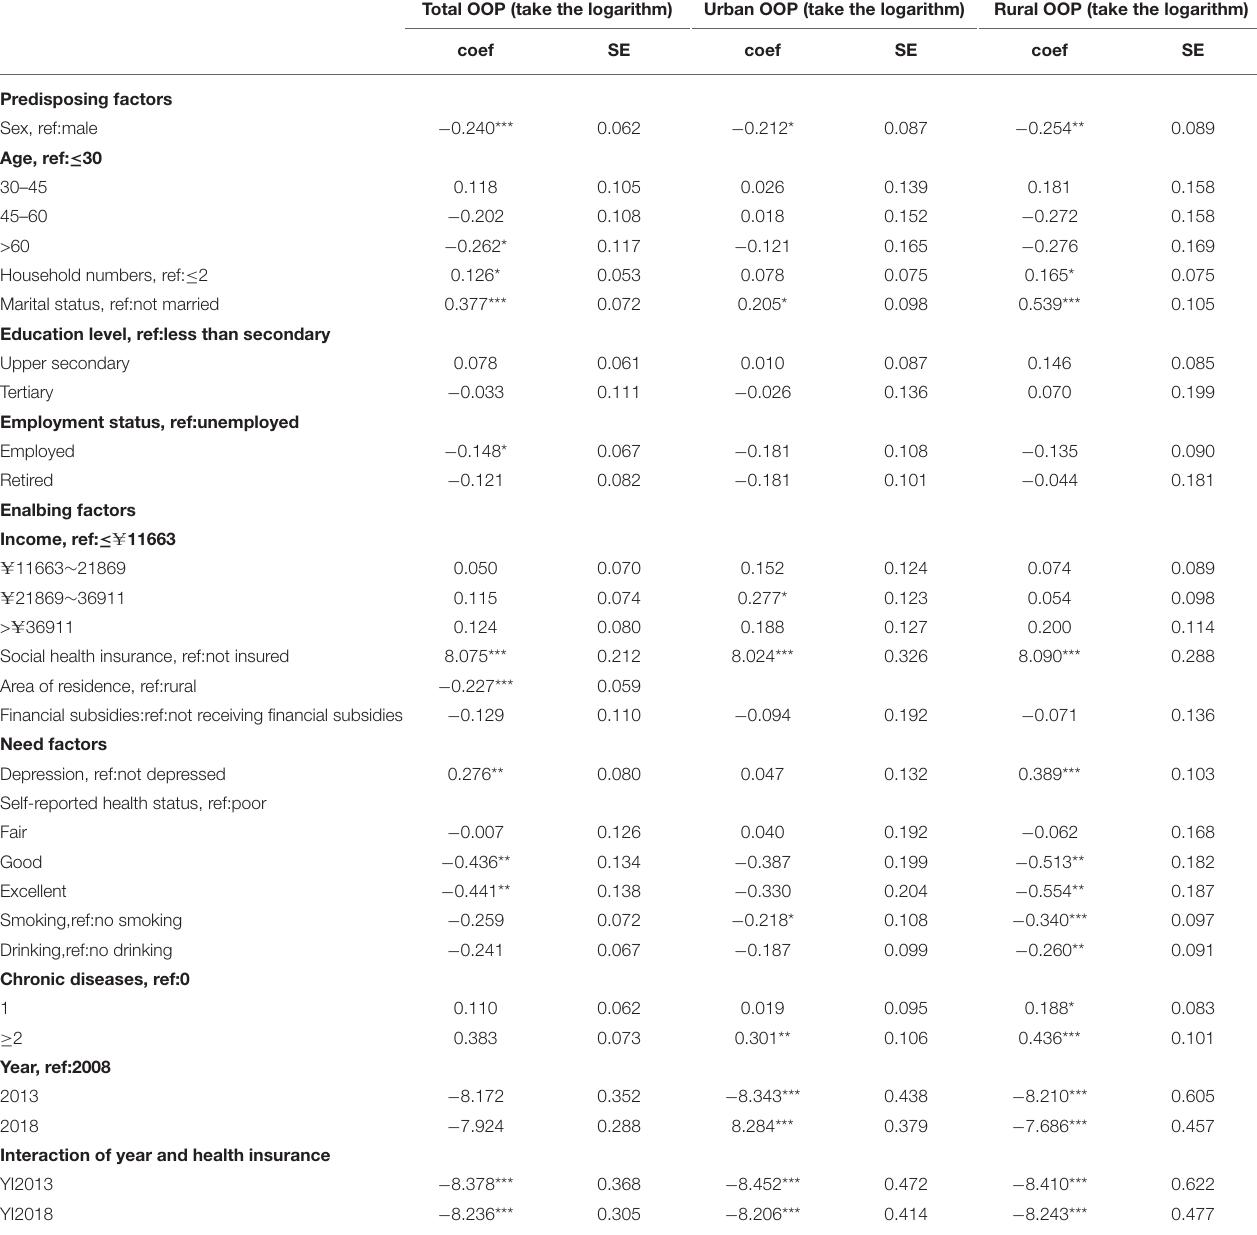
TABLE 4 | Regression of annual out-of pocket health expenditure of residents. Total OOP (take the logarithm) Urban OOP (take the logarithm) Rural OOP (take the logarithm) coef SE coef SE coef